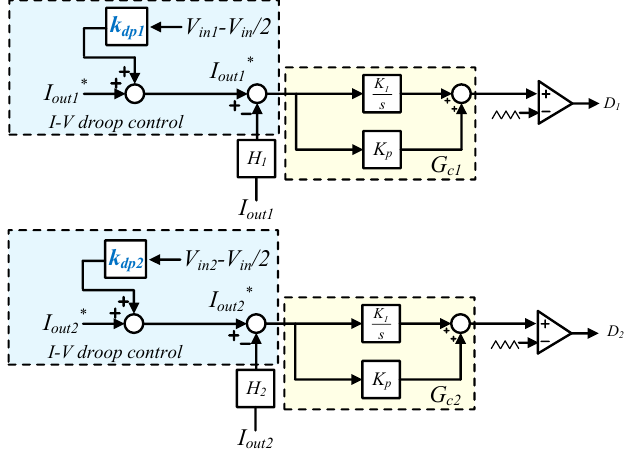
Figure 6. The proposed decentralized control block diagrams of ISOP converter.